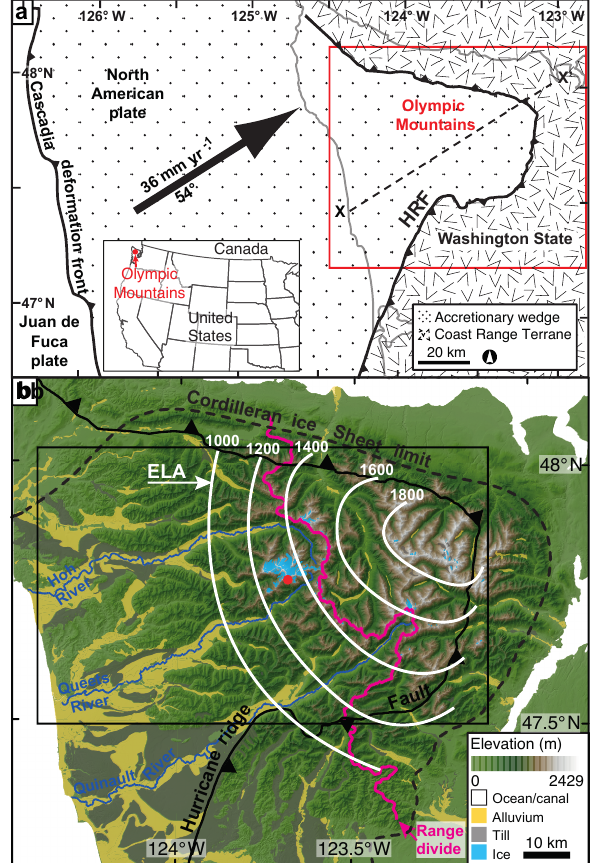
Figure 1. Topographic and geologic features of the Olympic Penin- sula, Washington State, USA. (a) Simplified geology based on Brandon et al. (1998). The relative velocity of the Juan de Fuca plate toward the North American plate is ∼ 36mmyr − 1 with a bearing of ∼ 54 ◦ (DeMets and Dixon, 1999). Red box denotes the extent of (b) . HRF – Hurricane Ridge fault. Grey lines outline the coast of Washington State. Dashed black line is the cross-section line for Fig. 7. (b) Elevation map of the Olympic Mountains. Ice, including extant alpine glaciers, is marked in blue. The limit of the Puget Lobe of the Cordilleran ice sheet (Vashon glaciation) is marked with a black dashed line (Porter, 1964). Undifferentiated Quaternary alpine glacial till and alluvial deposits are marked in grey and yellow, re- spectively (Washington Division of Geology and Earth Resources, 2010). Contours of Pleistocene equilibrium line altitudes (ELAs) from Porter (1964) are denoted by white lines (values shown in me- ters above sea level). Black box denotes the extent of Fig. 2 panels. A red dot marks Mount